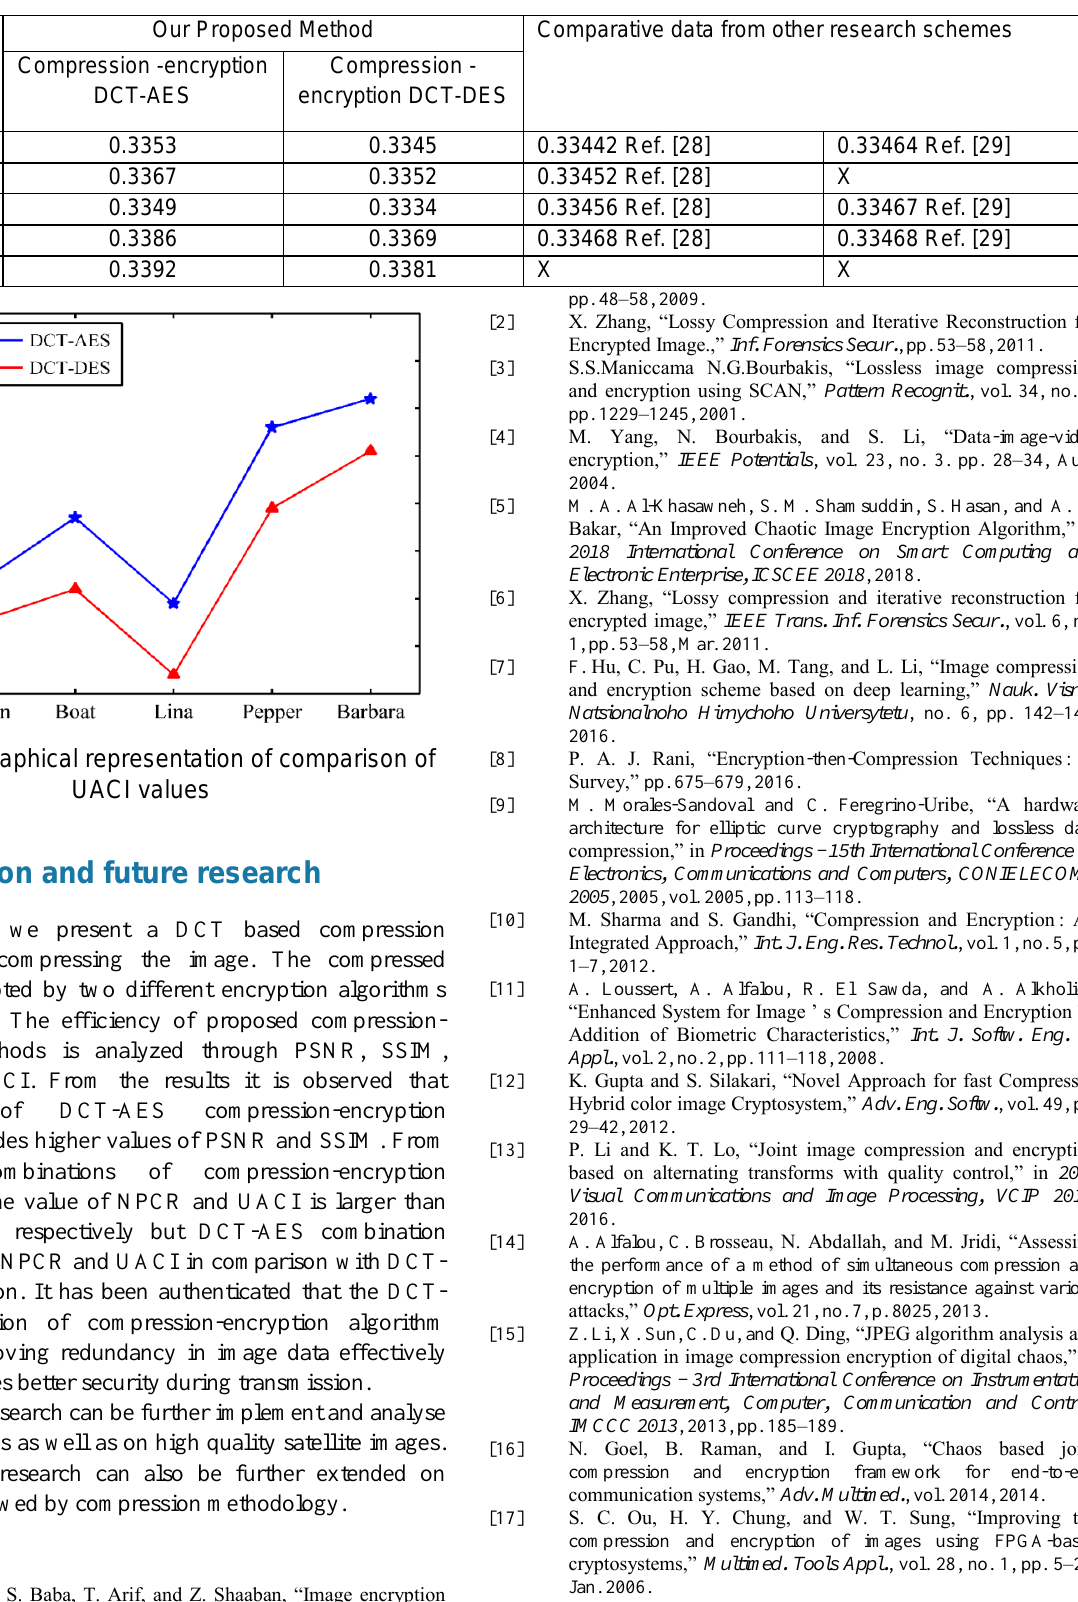
Table 4. Comparison of UACI values